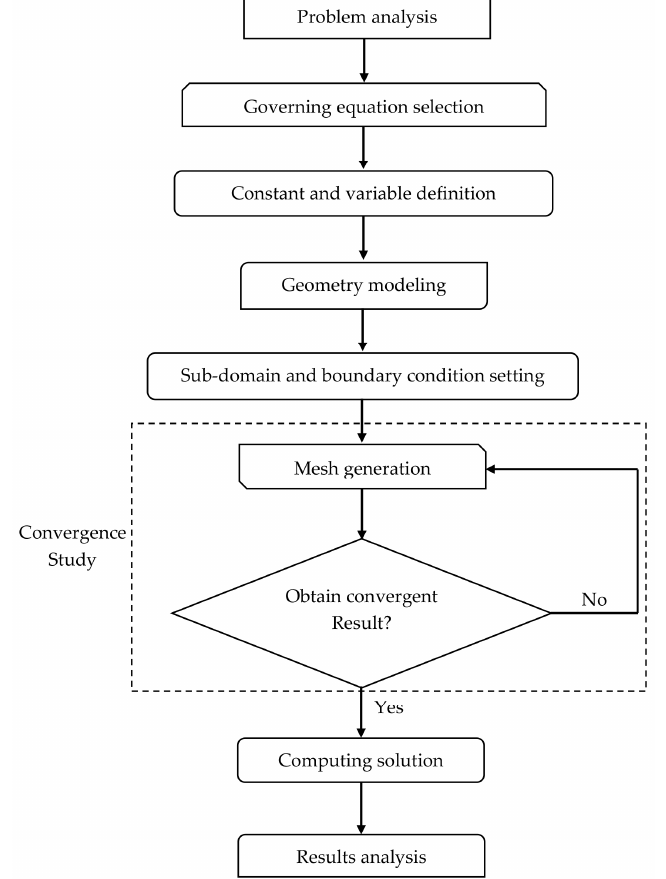
Figure 3 . Flowchart of the solution method.